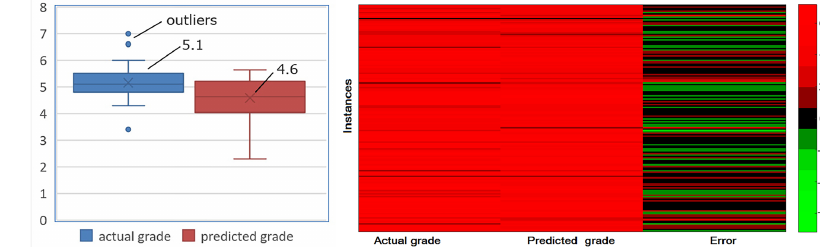
Fig. 10. Boxplot with mean values and heatmap of